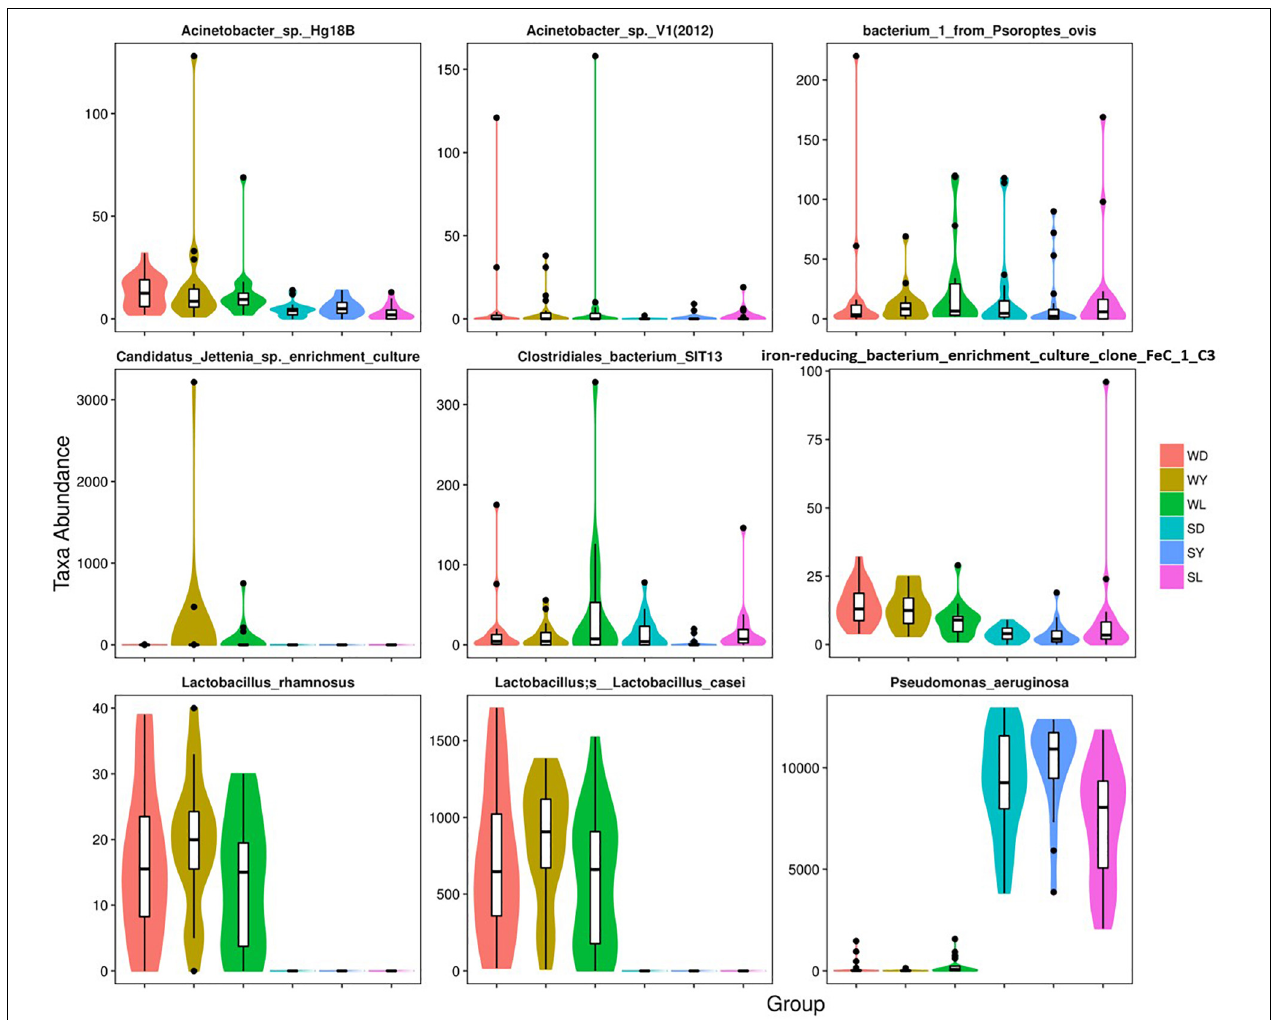
FIGURE 4 | Dominant bacterial species with significantly different distributions between the winter and summer. SD, samples collected from Duroc in summer; SL, samples collected from Landrace in summer; SY, samples collected from Yorkshire in summer; WD, samples collected from Duroc in winter; WL, samples collected from Landrace in winter; WY, samples collected from Yorkshire in